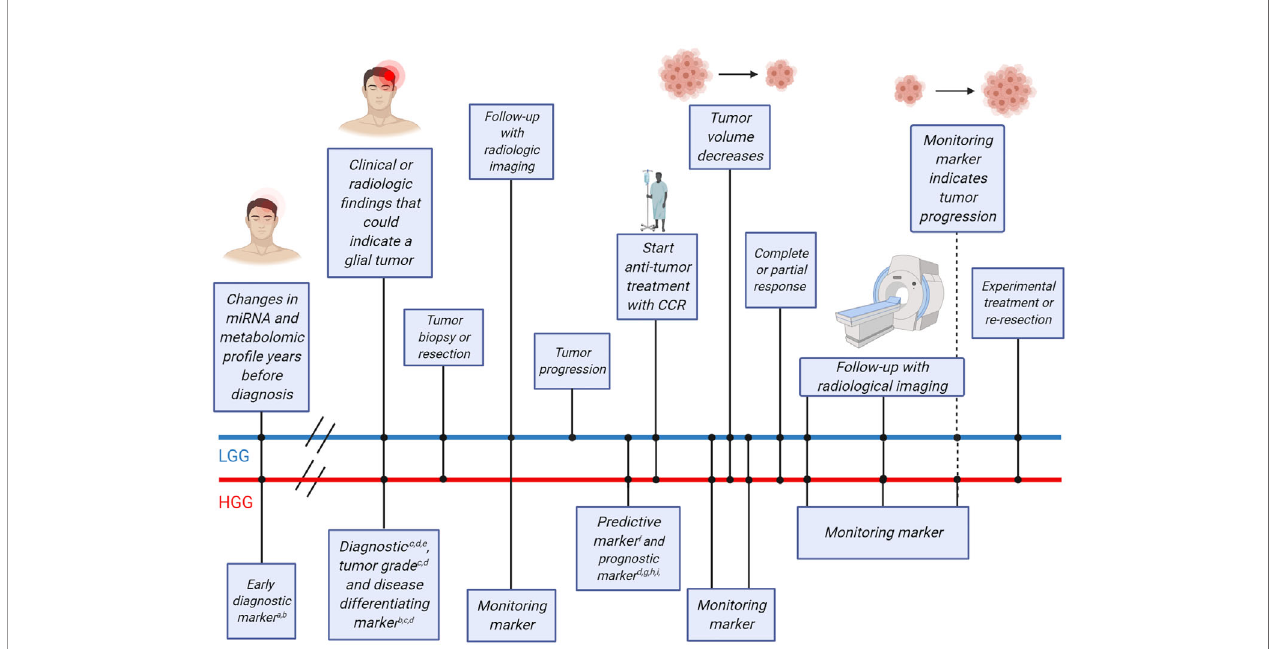
FIGURE 1 | Timeline of clinical events for glioma patients and possible blood-based biomarkers that could be employed at different points in time. The straight lines indicate timelines for two example glioma patients [upper blue line for a lower-grade glioma (LGG) patient, lower red line for a high-grade glioma (HGG) patient]. Clinical events that occur on either timeline are indicated using dots and the clinical events are described in boxes connected to the dots. Early diagnostic markers have been found more than two decades before glioma diagnosis and could be used as a screening tool in the healthy population for patients older than 50 years. At the time of clinical or radiological fi ndings that may indicate the growth of a glial tumor, diagnostic, tumor grade and disease differentiating biomarkers may be used to supplement the diagnostic procedure. Following, surgery (tumor tissue biopsy and/or tumor resection) may be performed, including either tumor resection or only a tumor tissue biopsy for de fi nite histopathological diagnosis. At this point, the brain tumor is identi fi ed as a HGG or LGG. Following discussion of the case in a multidisciplinary tumor board, treatment may be initiated in patients with more malignant tumor types, while patients with less malignant tumor types may be subjected to frequent follow-up using monitoring markers and radiological imaging to monitor potential tumor progression. At the moment of tumor progression in patients with less malignant tumors or directly after surgical resection in patients with malignant tumors, predictive markers may provide additional information on the potential bene fi t of adjuvant treatment. Anti-tumor treatment with conventional chemo- and/or radiotherapy (CCR) is currently usually initiated at this point. Monitoring blood markers can detect tumor volume decrease over time. Patients with complete or partial response can be followed using radiological imaging and monitoring markers to distinguish between tumor progression or pseudoprogression. Patients with stable disease, progressive disease or tumor progression after complete or partial response may be admitted for experimental treatments. For each biomarker purpose, several potential blood-based biomarkers are listed a Tocopherols; b miR-21; c GFAP; d Panels of miRNAs, proteins and metabolites; e IL-10; f NLR; g YKL-40; h F-NLR; i F-NLR-AGR. Figure was adapted from “ Cell Transfer Protocol ” , by BioRender.com (2021). Retrieved from: